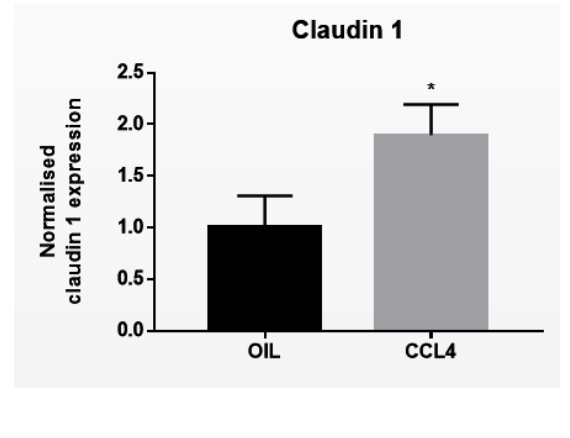
Figure 4: Effect of chronic liver disease on mRNA levels of hepatic cell junction compo- nents. Mice received injections with OIL or CCL4 for 8 weeks. mRNA was extracted from the liver and subjected to RT-qPCR analysis of E-cad- herin, β-catenin, γ-catenin, Cx26, Cx32, Cx43, zonula occludens 2 and claudin 1. Fold changes in mRNA levels were calculated, where the aver- age expression of OIL-treated animals was set to 1. Results were analyzed by 2-tailed unpaired stu- dent t-tests and Welch’s correction. Data were ex- pressed as means ± SD (* p ≤ 0.05) ( n = 8-10; N =